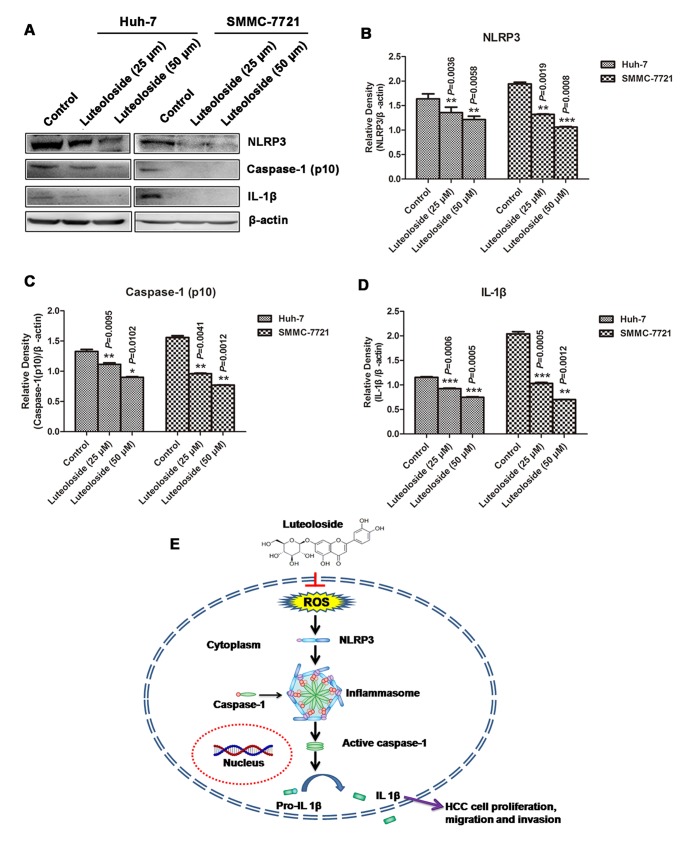
Luteoloside suppresses the NLRP3 inflammasome activation.(A) Western blot analyses of NLRP3, Caspase-1 (p10) and IL-1β protein expression in Huh-7 and SMMC-7721 cells exposed two different concentrations of luteoloside for 48 h. (B–D) Relative quantitation of NLRP3, Caspase-1 (p10) and IL-1β. (E) A hypothetical cascade pathway of NLRP3 inflammasome suppressed by luteoloside. *, P<0.05; **, P<0.01; ***, P<0.001, versus non-luteoloside-treated control group.